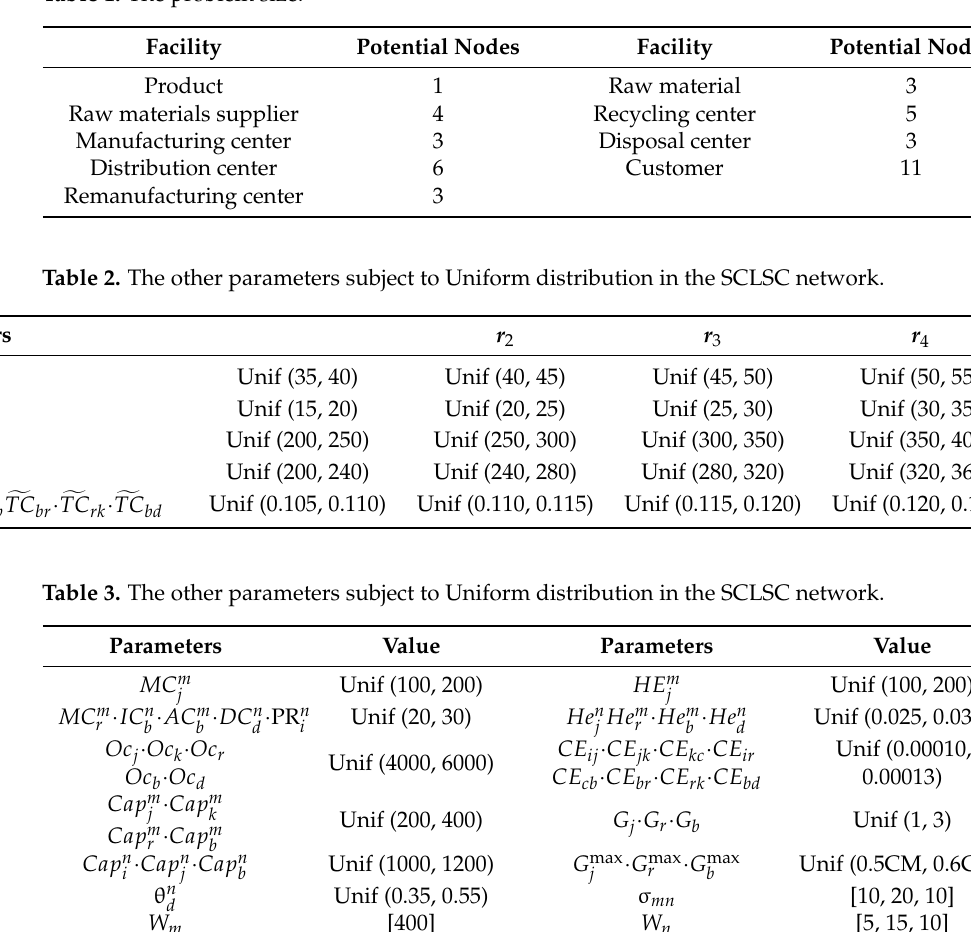
Table 1. The problem size.